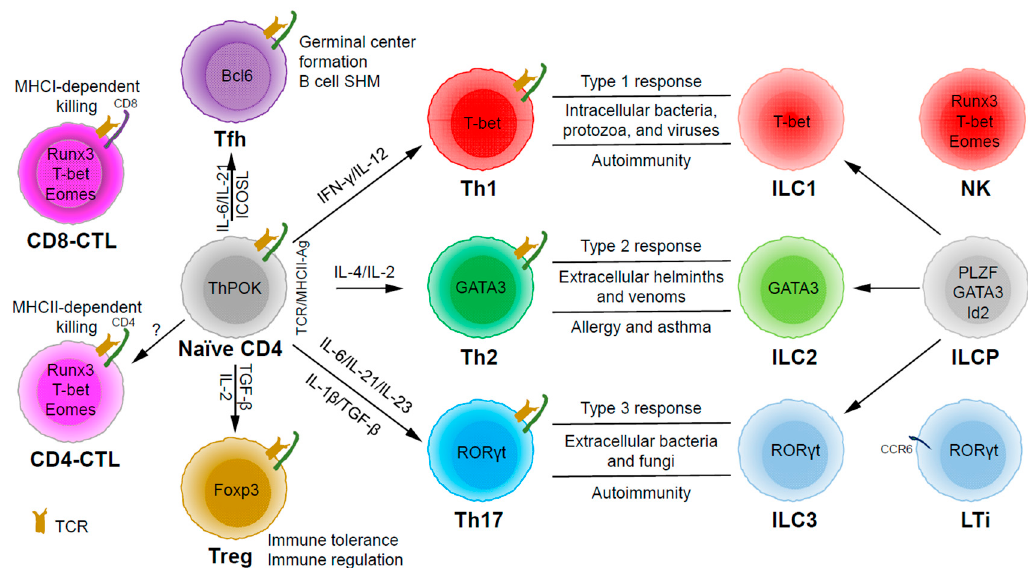
Figure 1. The development and functions of CD4 T helper (Th) and innate lymphoid cell (ILC) subsets. Naïve CD4 T cells can differentiate into Th1, Th2, Th17, Tfh (follicular T helper), and Treg (T regulatory) subsets upon T cell receptor (TCR) activation in different cytokine milieu. T cells may also become cytotoxic CD4 T cells (CD4-CTLs) that kill their target cells in major histocompatibility complex class II (MHCII)-restricted manner. ILC1, ILC2, and ILC3 subsets are the innate counterparts of Th1, Th2, and Th17 cells and they are involved in type 1, type 2, and type 3 immune responses, respectively. ILC1, ILC2, and ILC3 subsets develop from ILC progenitors (ILCPs), which are distinct from progenitors that give rise to natural killer (NK) cells and lymphoid tissue inducers